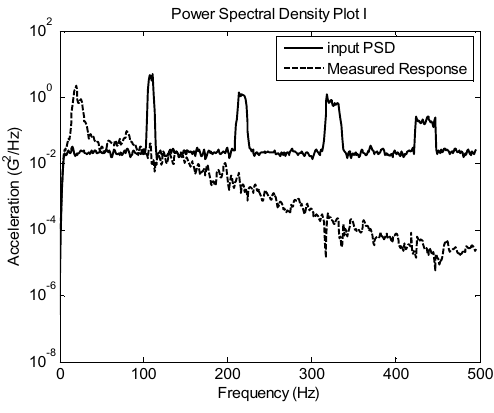
Fig. 13. PSD plot for vibration isolation system I.